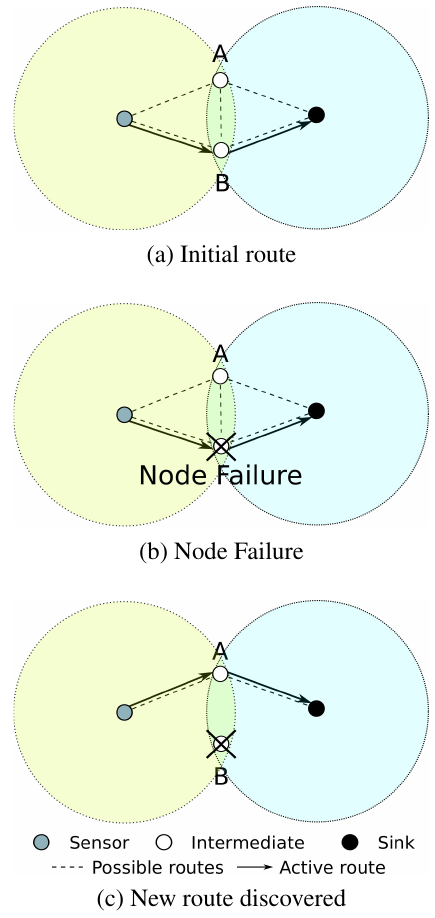
Fig. 16: Intermediate node failure test Figure 16. Intermediate node failure test.